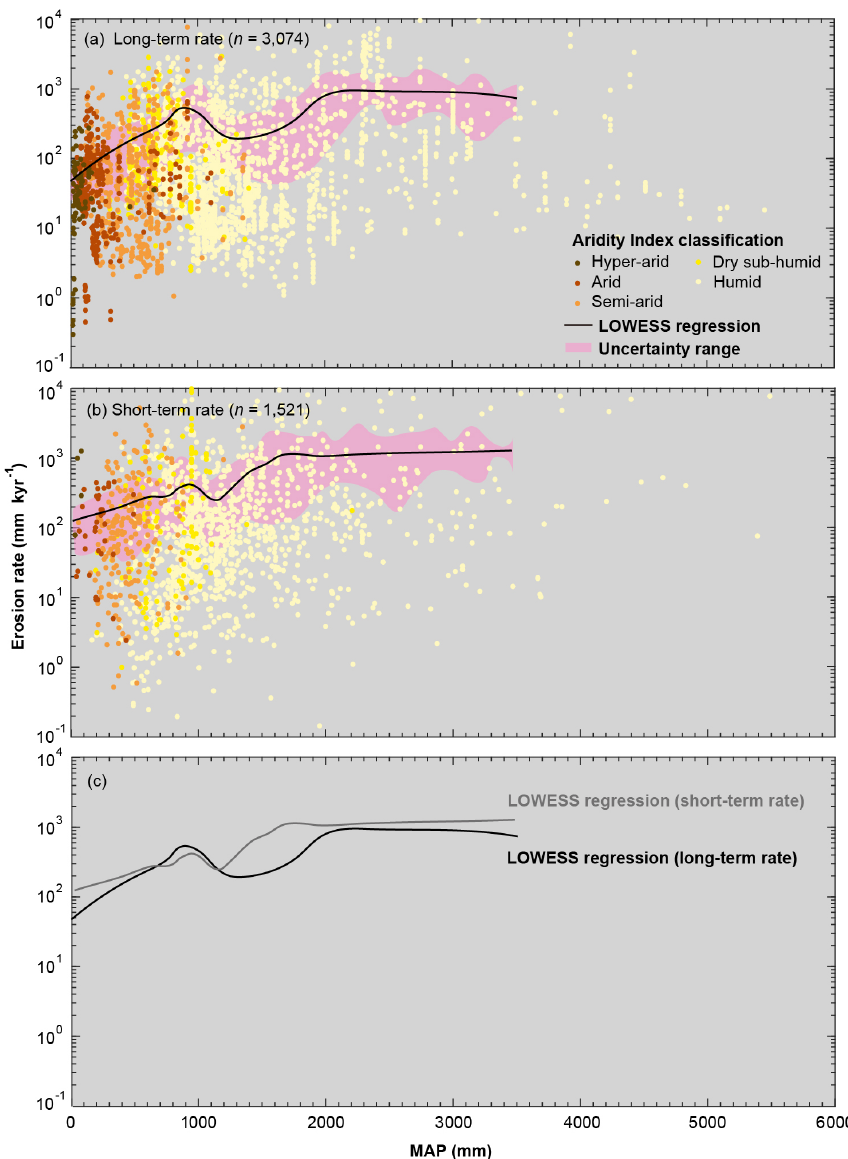
Figure 4. Relationships between mean annual precipitation (MAP) and (a) long-term erosion rates and (b) short-term erosion rates. Points are colour coded by Aridity Index categories. The black curve in each panel is the LOWESS regression, and the pink shading represents the uncertainty of the regression. (c) Comparison between LOWESS regressions between long- and short-term erosion rates. The regressions are truncated at extremely humid regions (MAP > 3500mm) owing to the limited number of data points in these